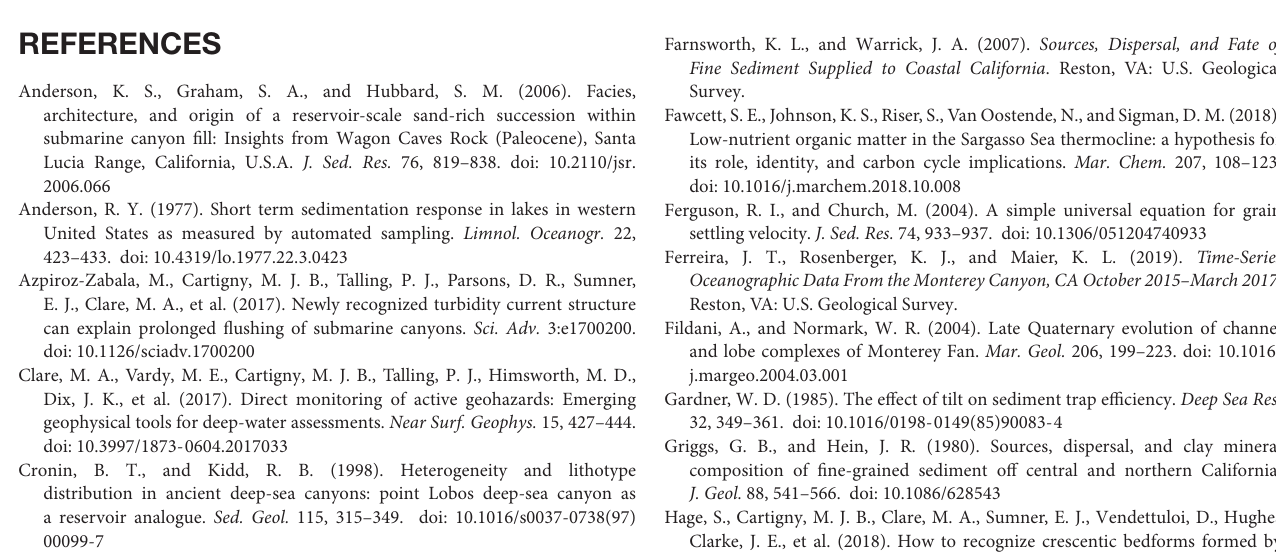
TABLE S1 | Grain size summary for sediment density flow events in sediment traps. TABLE S2 | Grain size summary for pushcore